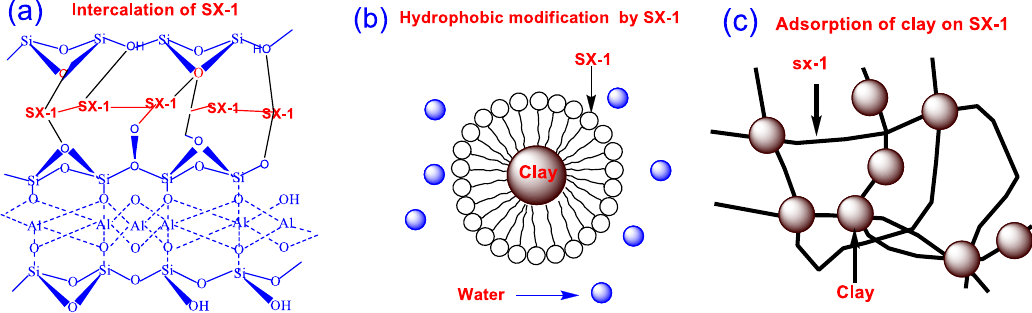
Figure 12. Inhibition mechanism analysis of SX-1. ( a ) Intercalation of SX-1. ( b ) Hydrophobic modification by SX-1. ( c ) Adsorption of clay on SX-1.